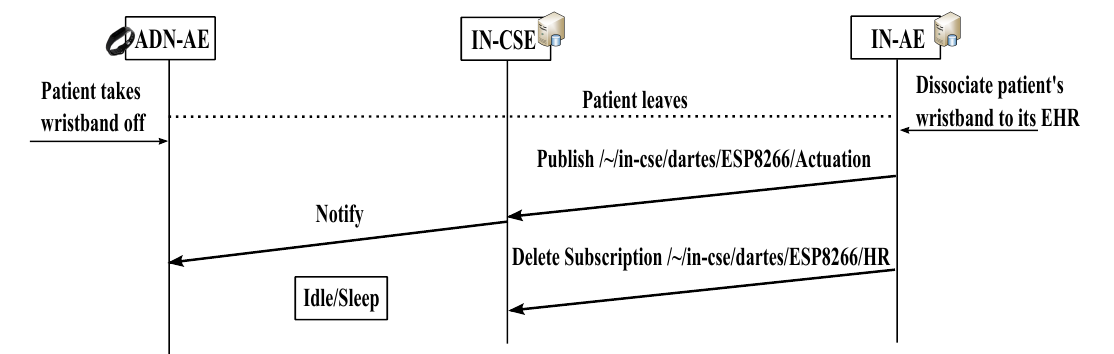
Figure 4. Messages exchanged when the patient takes the wristband off and leaves the ward.